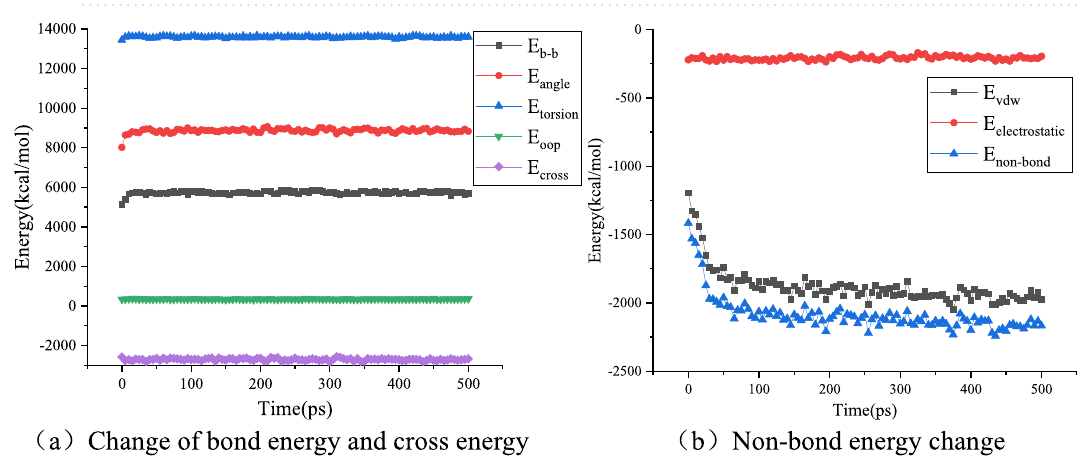
Figure 15. Energy change during aged asphalt self-healing process.